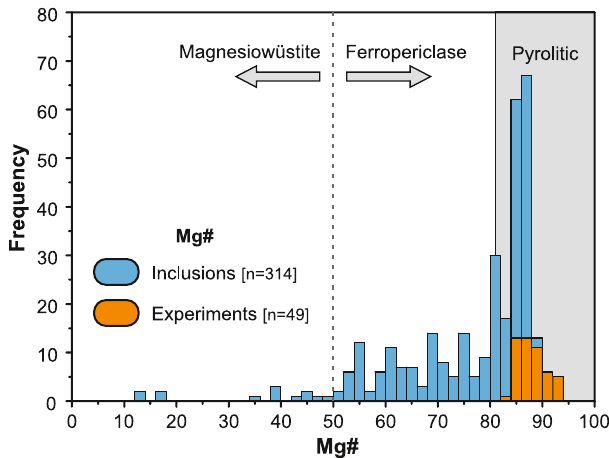
Fig. 1 | Mg# of (Fe,Mg)O inclusions in diamonds from localities worldwide and selected experimental studies in pyrolite and fertile lherzolite KLB-1 compo- sitions. References to the literature data are listed in Supplementary